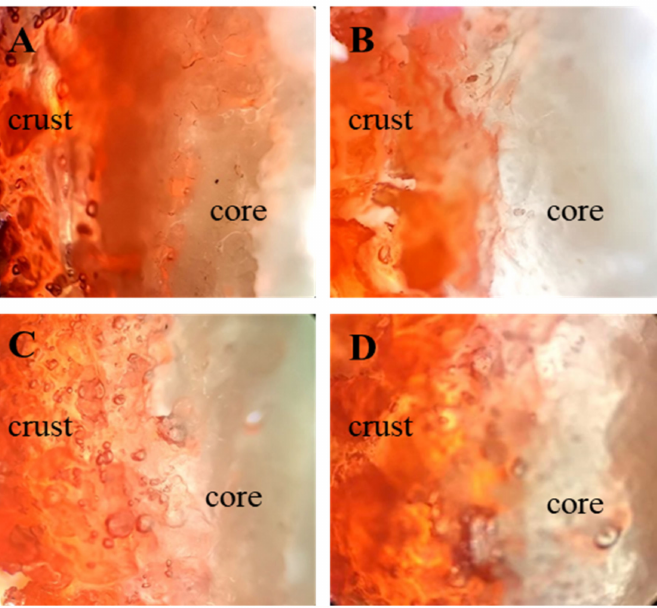
Figure 4. Effect of added proteins on oil penetration of fried BBFNs. All the images were taken at 4 × magnification in reflective mode. ( A – D ) represent the control (without protein added to the batter), soy protein, egg white protein, and whey protein,